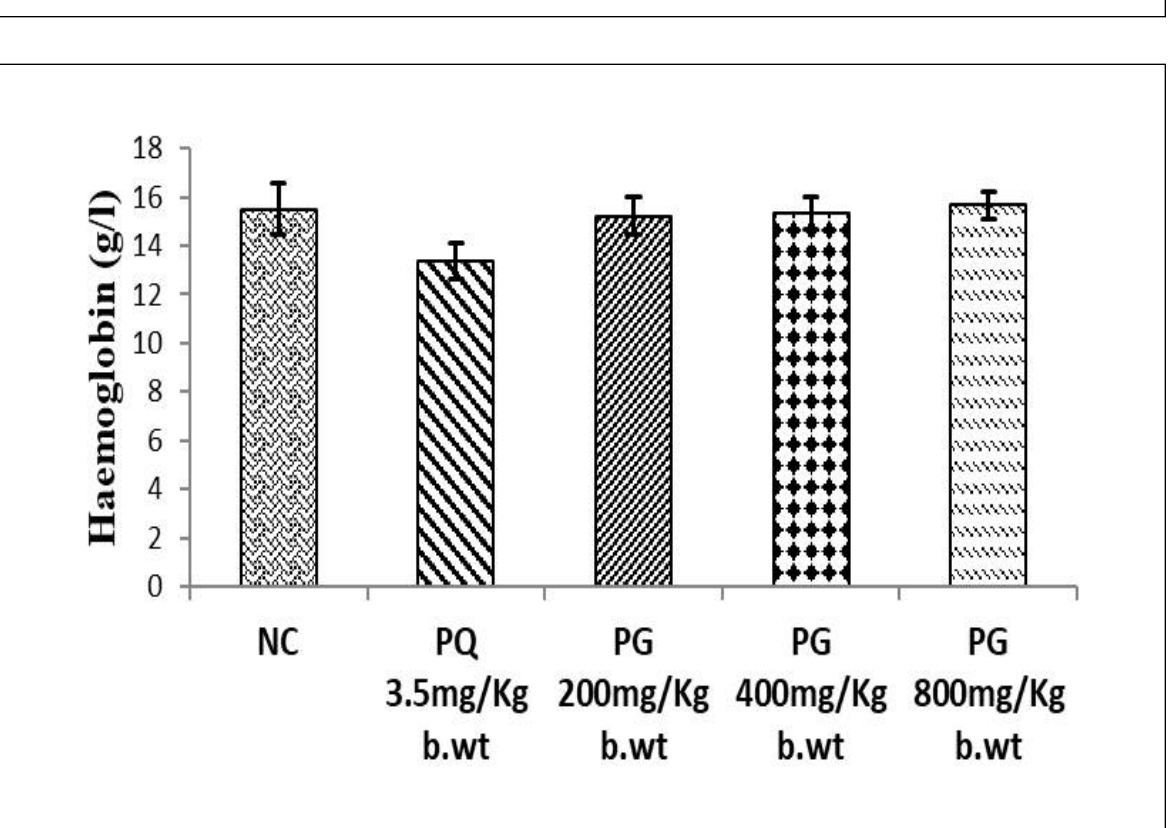
Figure 11: Effect of Psidium guajava leaf extract administration on hemoglobin concentration of male Wistar albino rats administered 3.5 mg/kg b.wt.